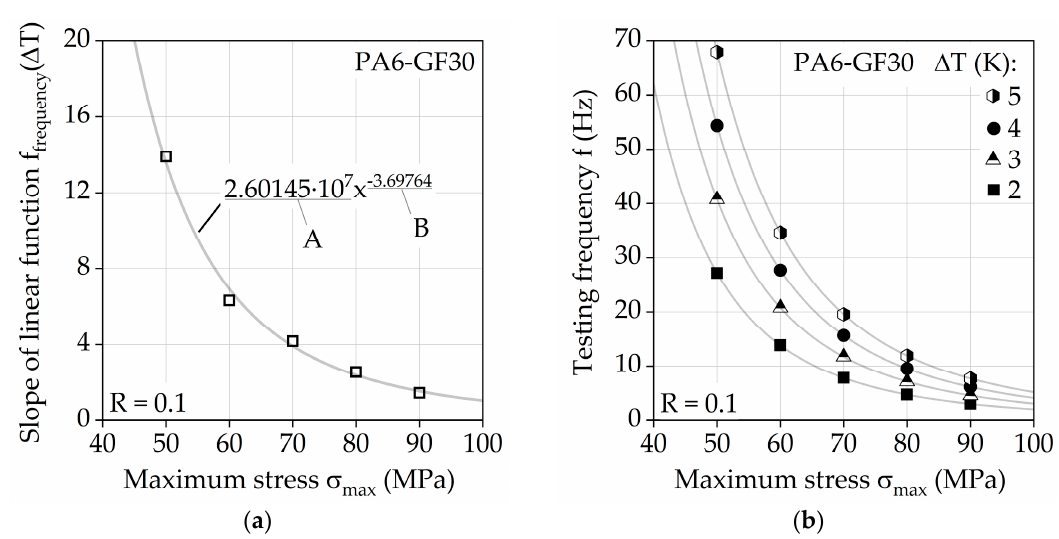
Figure 7. ( a ) Results of multiple frequency test at σ max = 70 and 80 MPa; ( b ) linear temperature–testing frequency relationship visualized for σ max = 50, 60, 70, 80 and 90 MPa.